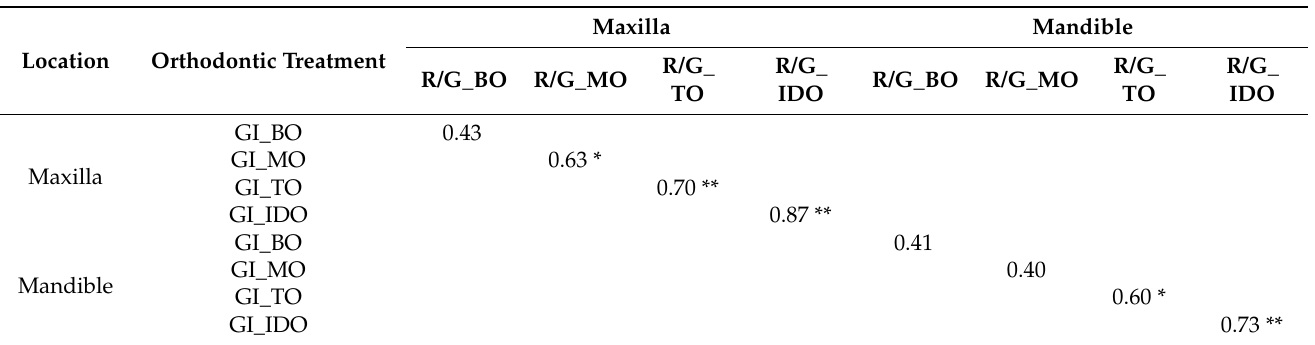
Table 5. Correlation analysis between the highest GI and R/G values of each maxillary and mandibu- lar